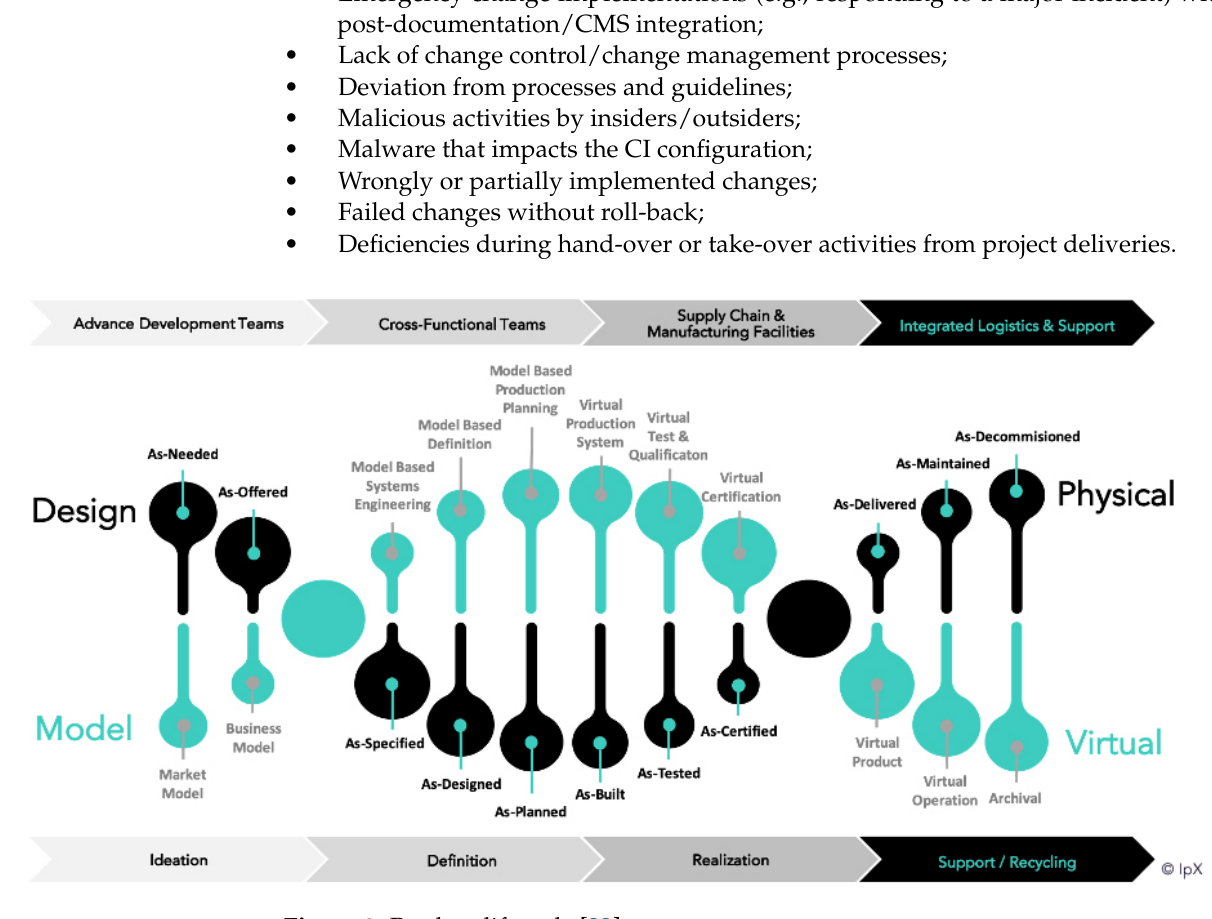
Figure 3. Product lifecycle